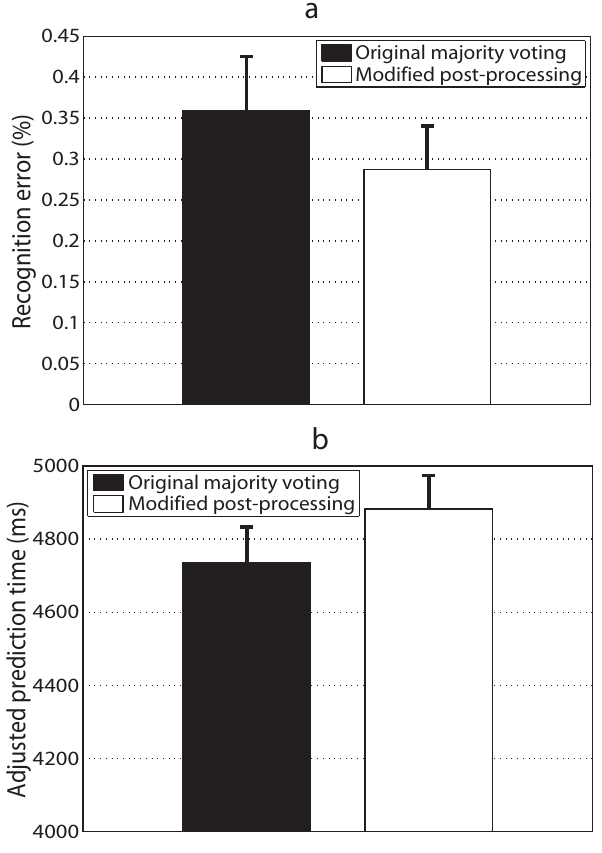
Average recognition error ( a ) and adjusted prediction time ( b ) over seven able-bodied subjects with the original majority voting and the modified post-processing approach. Error bars denote SEMs across